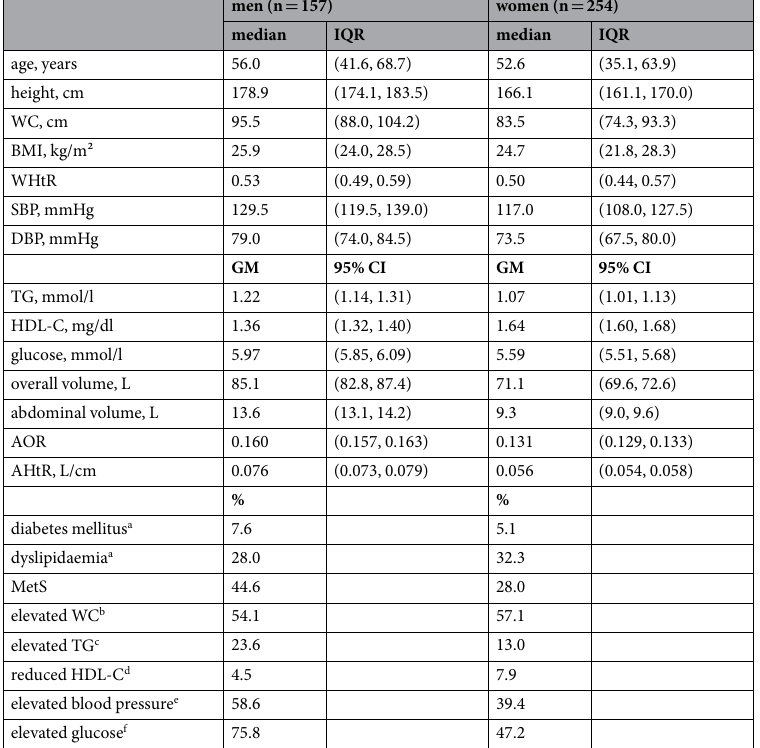
Table 1. Basic characteristics of participants of MetScan, 2016-2017, total (N = 411). AHtR, abdominal- volume-to-height ratio; AOR, abdominal-to-overall-volume ratio; BMI, body mass index; DBP, diastolic blood pressure; GM, geometric mean; HDL-C, high-density lipoprotein cholesterol; IQR, interquartile range; MetS, Metabolic Syndrome; SBP, systolic blood pressure; TG, triglycerides; WC, waist circumference; WHtR, waist- to-height ratio; 95% CI, 95% confidence interval. Information on age and history of diabetes and dyslipidaemia was derived from self-reports during a personal interview; manual anthropometric and 3D body scan measures, blood pressure as well as fasting blood samples were taken by trained personnel a self-reported physician- diagnosed disease b men, ≥ 94 cm; women, ≥ 80 cm 5 c ≥ 1.7 mmol/L 5 d men, < 1.0 mmol/L; women, < 1.3 mmol/L 5 e of three sitting blood pressure measurements) or reported diagnosis of hypertension 5 f ≥ 5.6 mmol/L (or,